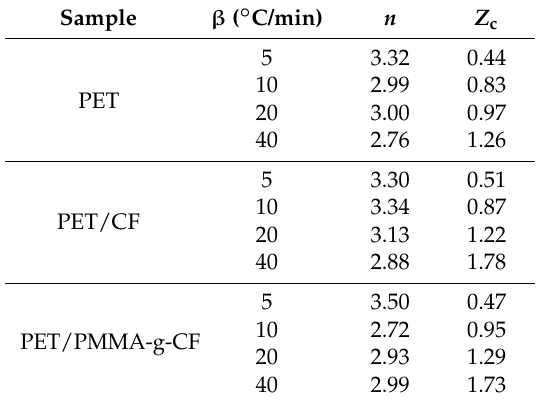
Table 4. Non-isothermal crystallization kinetic parameters based on the Jeziorny-modified Avrami equation. Sample β ( ◦ C/min) n Z c